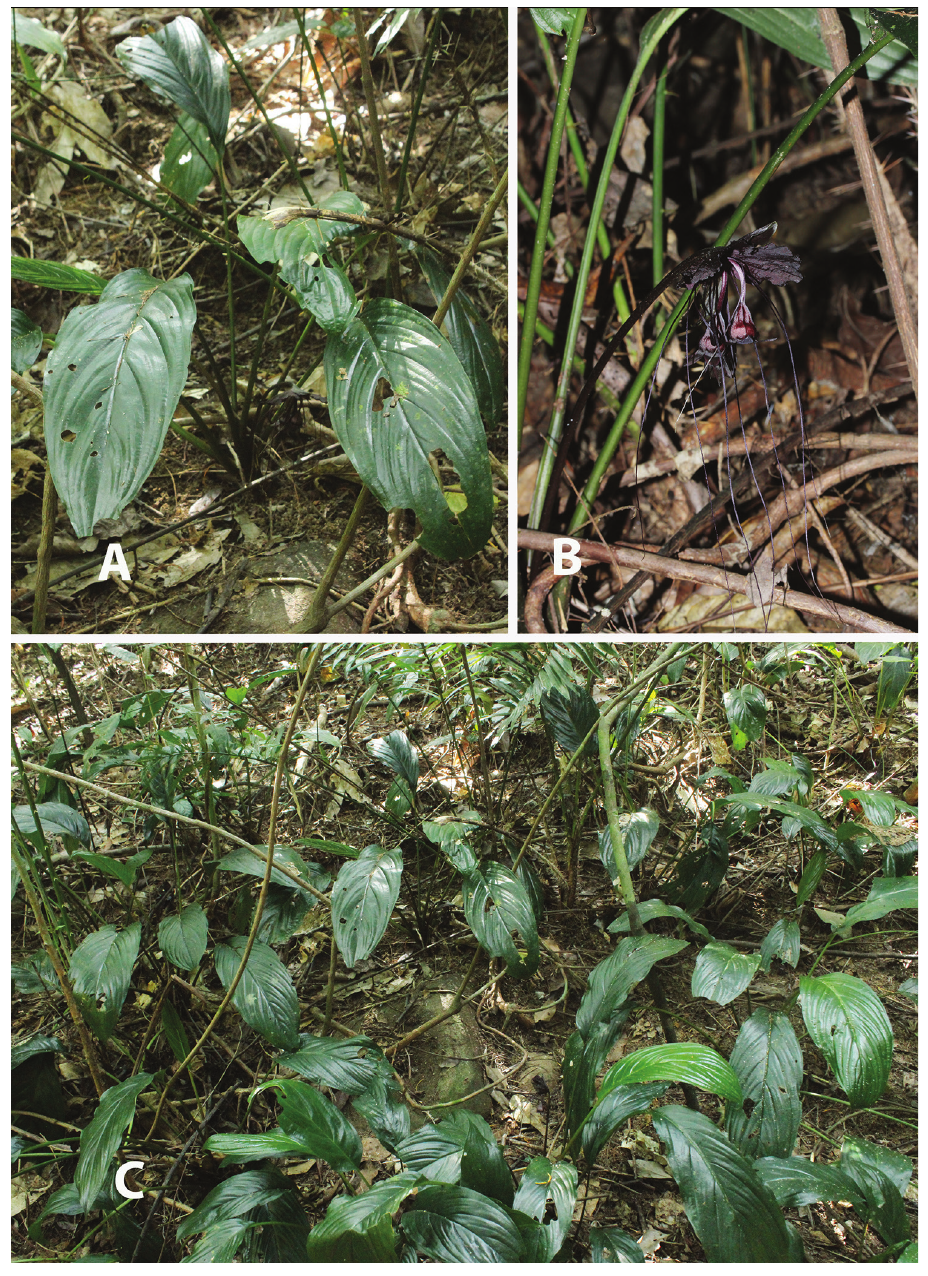
Figure 2. Tacca khanhhoaensis V.S. Dang & Vuong. A Habit B Inflorescent much shorter leaves C